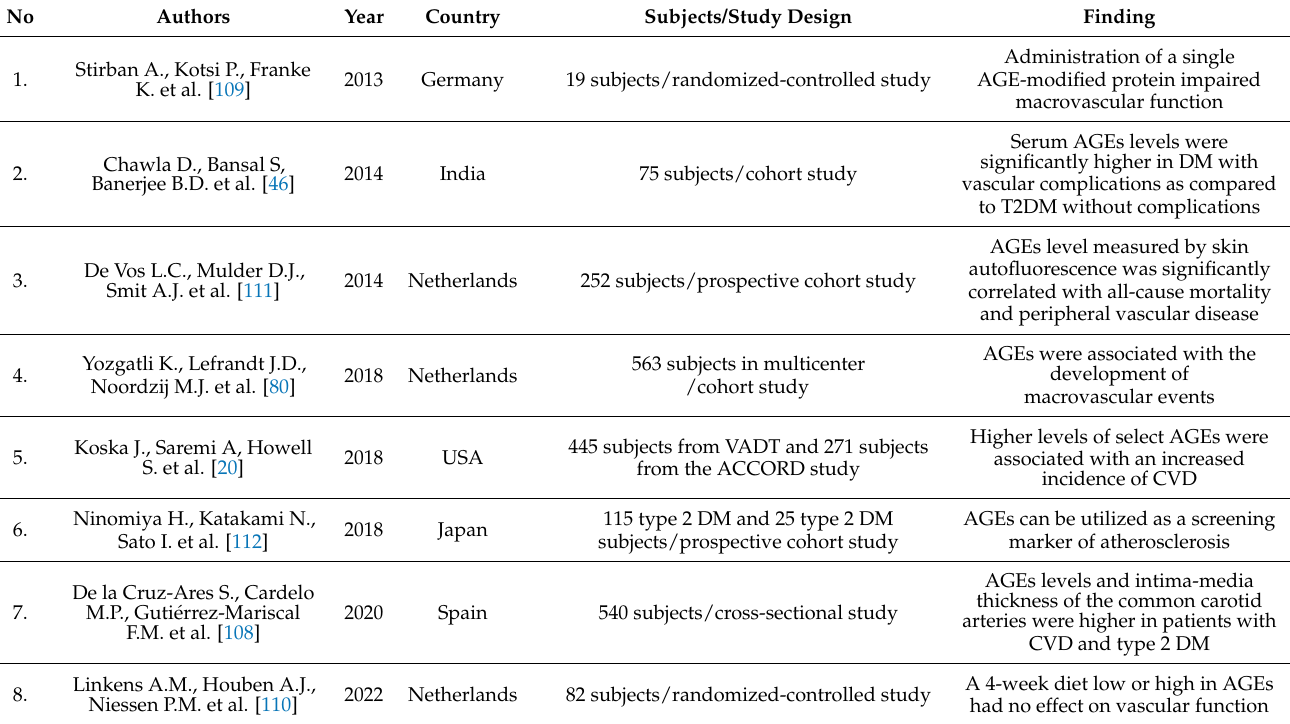
Table 2. Clinical studies—an association between macrovascular complications and AGEs/RAGE in type 2 DM; Investigation of recent research within 10